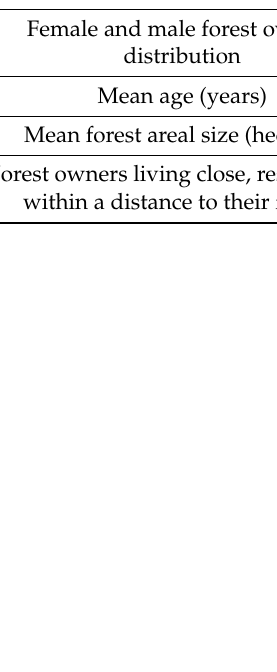
Table 3. Description of participants in this study compared to Swedish forest owners’ statistics [3]. Study Participants